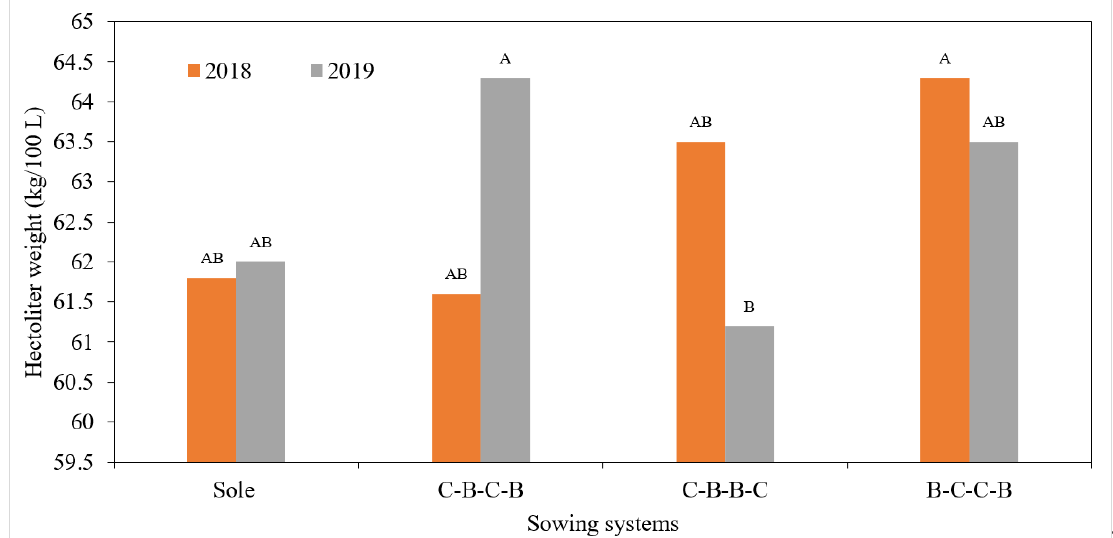
Figure 4. The interactions of maize-white bean sowing systems on hectoliter weight at Nur Sultan, Kazakhstan research station. Letters on each bar represent a significance level at p < 0.01. Note: different letters denote significant differences, while the same letters indicate insignificantly different values.